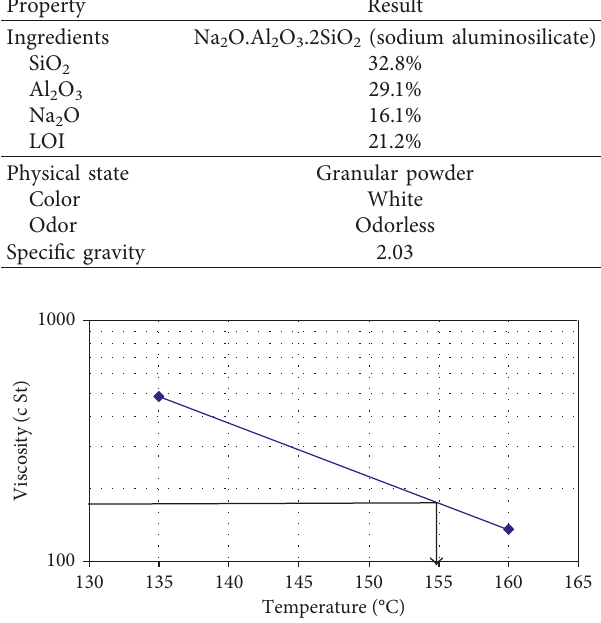
Figure 5: Viscosity-temperature chart of PG 64-16.